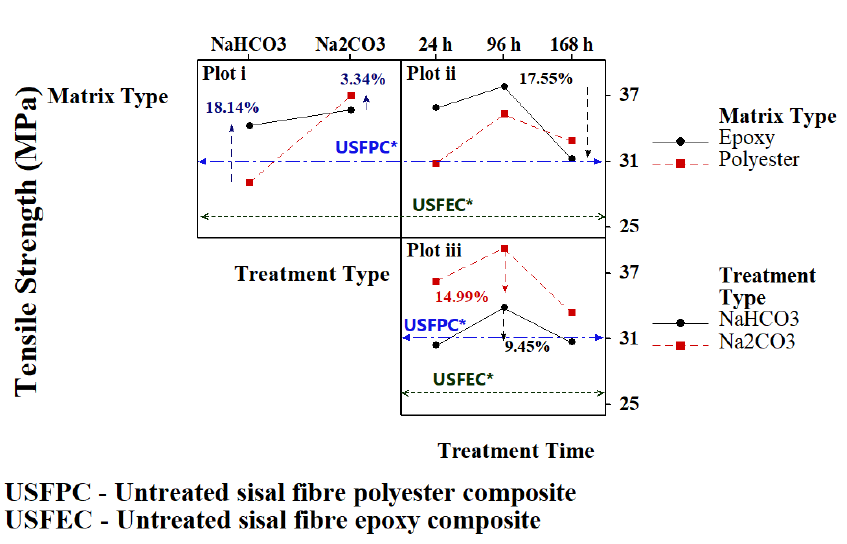
Figure 3. Tensile testing plots for DoE: tensile strength interaction plots for i) Matrix type x Treatment Type; ii) Matrix type x Treatment time, and iii) Treatment Time x Treatment